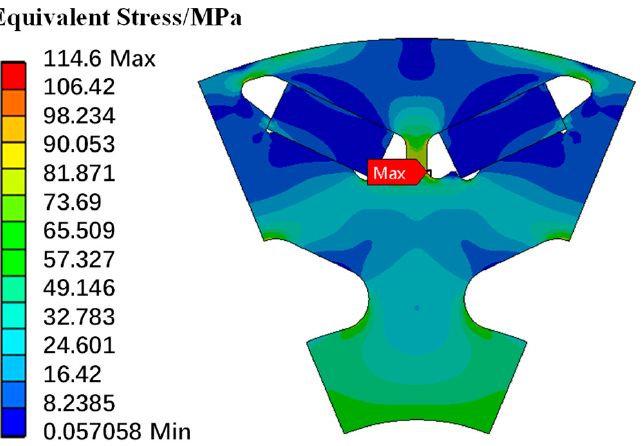
Figure 15. Rotor stress distribution under coupled thermomechanical fields.